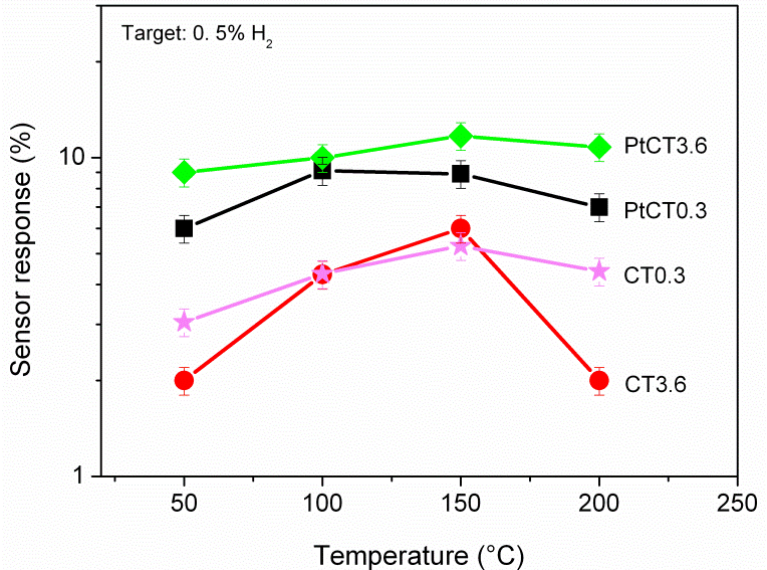
Figure 5. Response of the sensors investigated at different operating